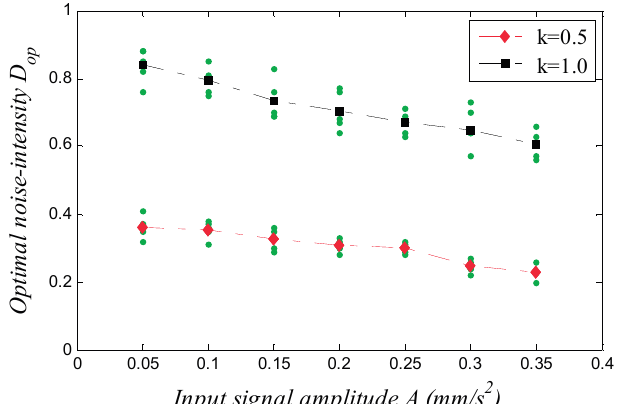
D for SR to occur in a Duffing op